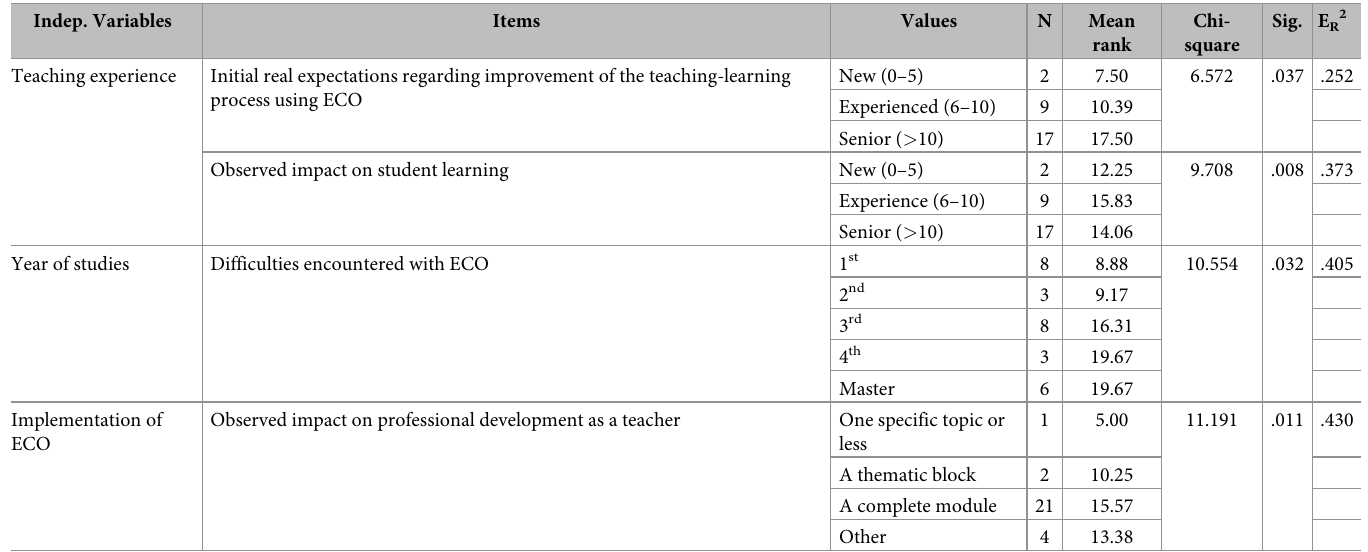
Table 3. Kruskal-Wallis H test